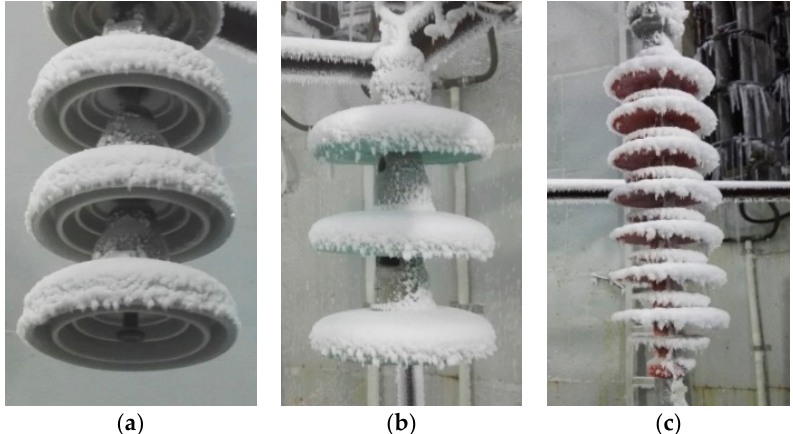
Figure 4. Appearance of snow-covered insulator strings in the artificial climate chamber. ( a )